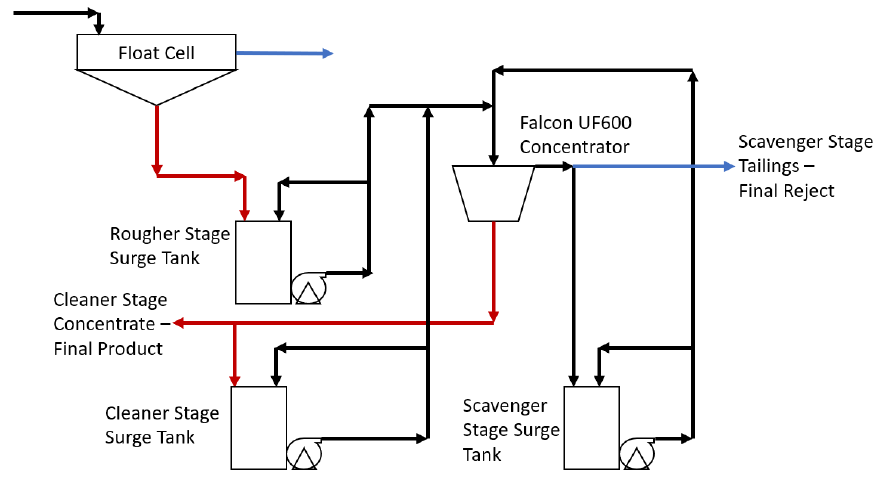
Figure 2. Replacement of TANCO gravity circuit with a single Falcon UF 600, recreated for legibility [4].